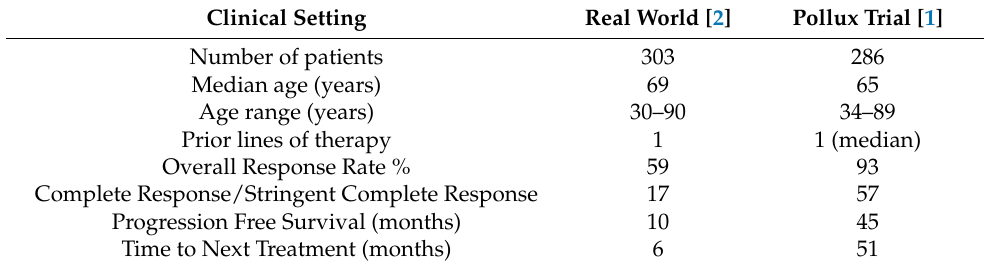
Table 1. Comparison of patient populations and response to second line therapy of myeloma.